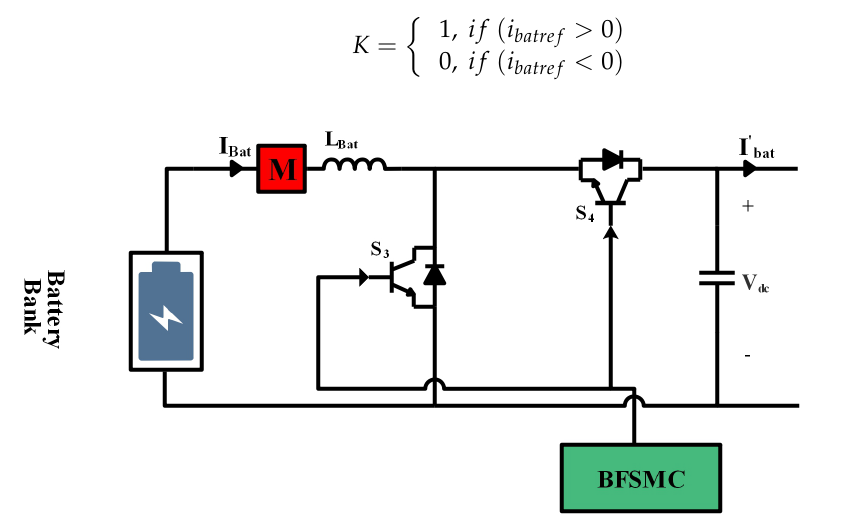
Figure 4. Battery bank